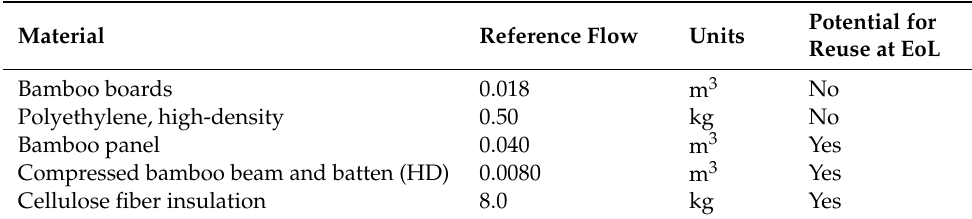
Table 3. Bill of materials for one functional unit (FU = 1 m 2 ) of bamboo-based wall assembly. Reference flow = amount of material required per